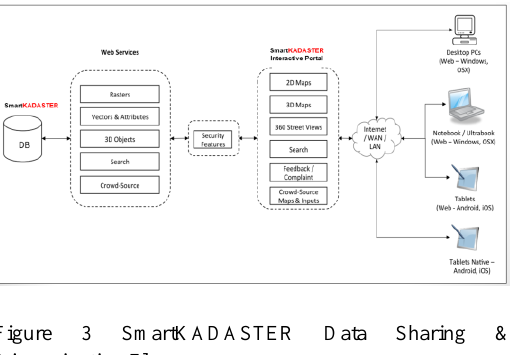
3 SmartKADASTER Data Sharing & Dissemination Flow